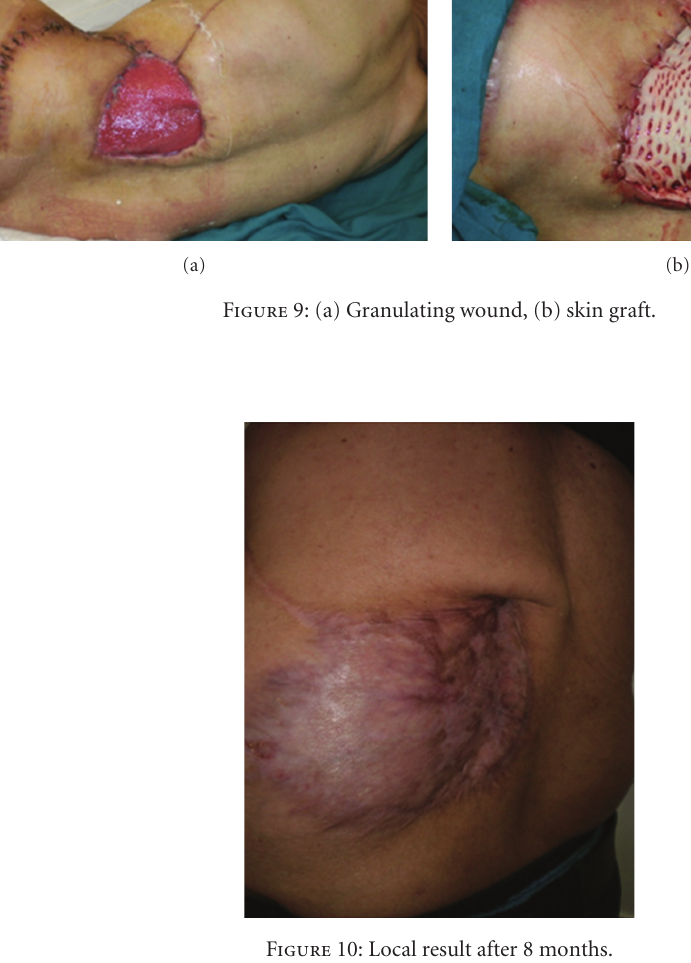
Figure 10: Local result after 8